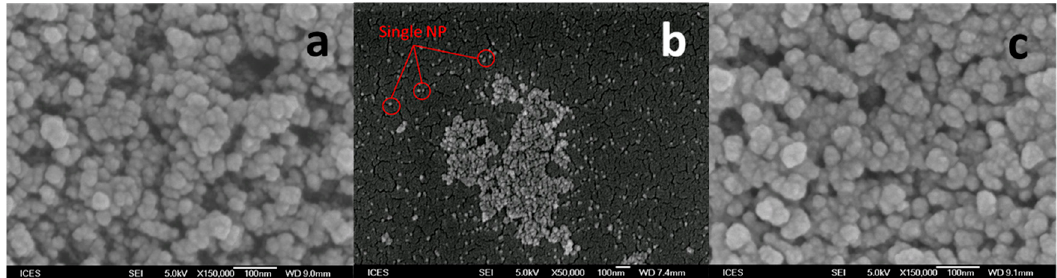
Figure 2. Scanning electron microscope (SEM) image of nanoparticles: ( a ) FNP; ( b ) ANP; ( c ) FNP-MD.